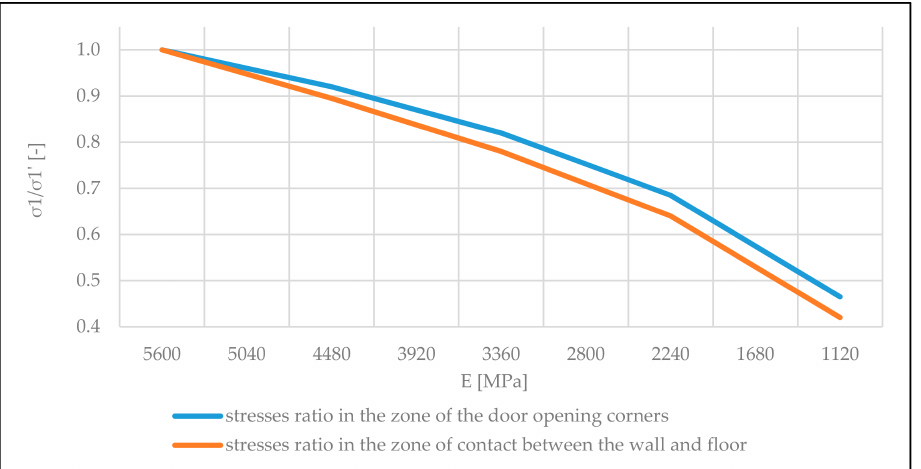
Figure 10. Graph of the dependency between σ 1 / σ 1 (cid:48) ratio and wall modulus of elasticity E [MPa] ( σ 1 —main tensile stress with a lowered modulus of elasticity and σ 1 (cid:48) –stress for modulus of elasticity E = 5600